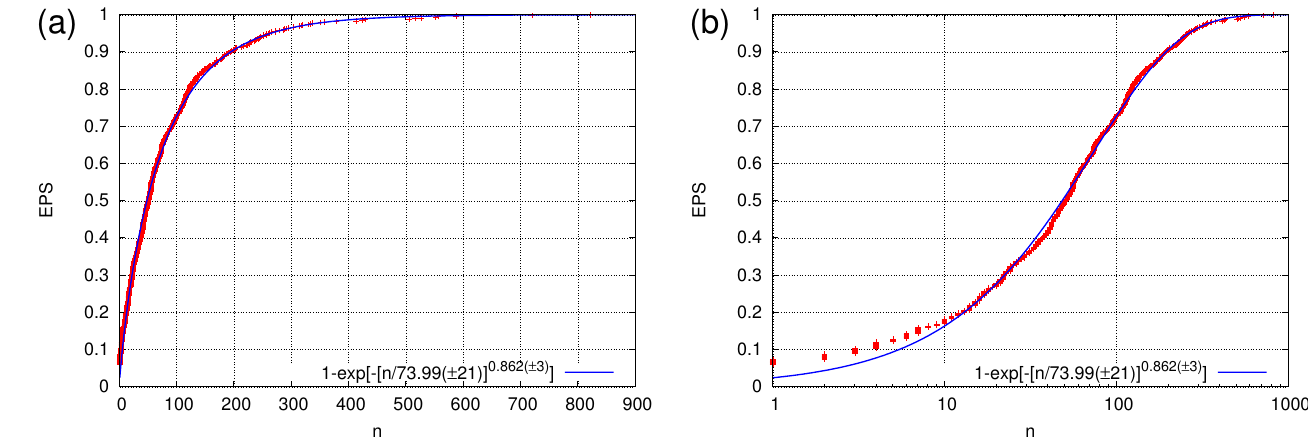
Figure 3. The EPS versus the number n of ‘small’ EQs with M ≥ 5.0 that occur during the period between two ‘large’ EQs of magnitude M ≥ 7.0 in the globe (see Figure 1) as estimated by the empirical cumulutive distribution function (red plus symbols) or its Weibull model fit [109,110,112] (blue line). Panels ( a , b ) correspond to lin-lin and lin-log diagrams, respectively. They have been both drawn for the readers’ better